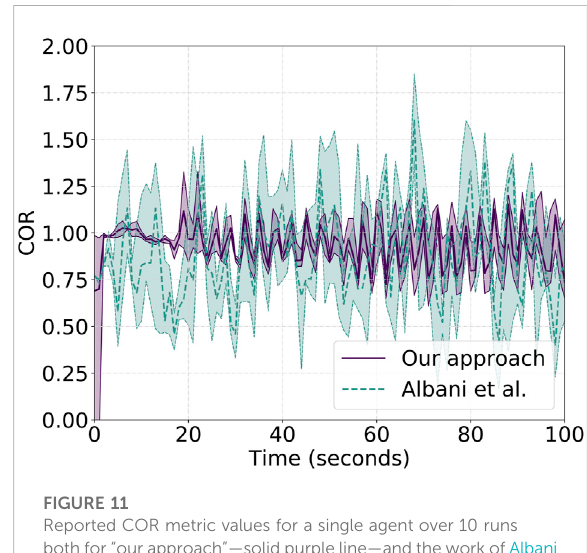
FIGURE 11 Reported COR metric values for a single agent over 10 runs both for “ our approach ”— solid purple line — and the work of Albani et al. (2022) — dashed light-green line. Close to 1 y-values show better COR